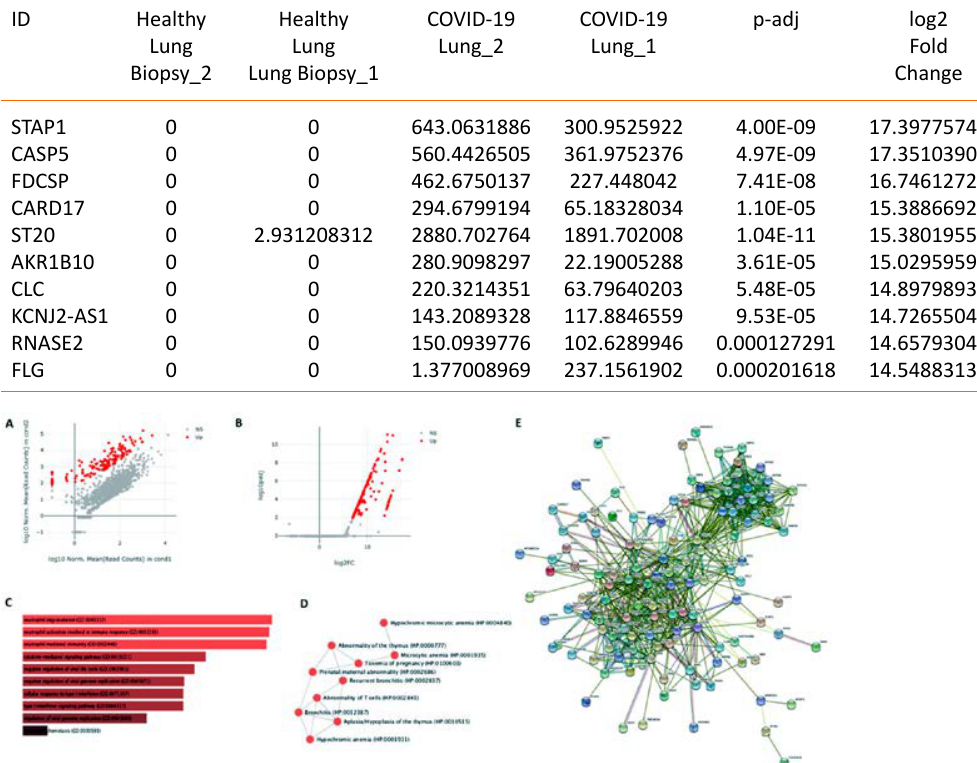
Fig. 2. (A) Scatter Plot (log10 Normalized Mean (Read Counts) in condition 1 against log10 Normalized Mean (Read Counts) in condition 2); (B) Volcano Plot (log10 padj. Vs log2 FC); (D) GO – Biological Process; (D) Human Phenotype Ontology; (E) PPI network of screened significant